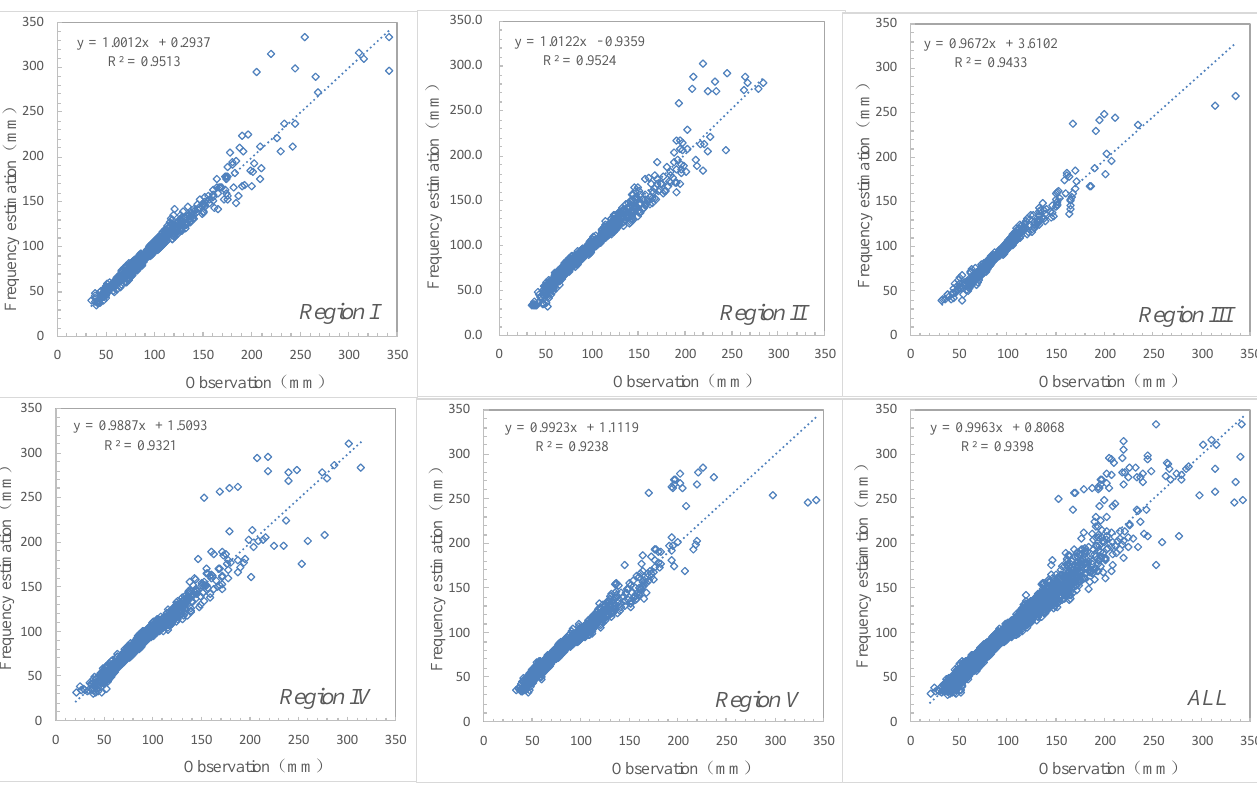
Figure 5. Scatterplot of estimations and observations at the same frequency for each homogeneous region.